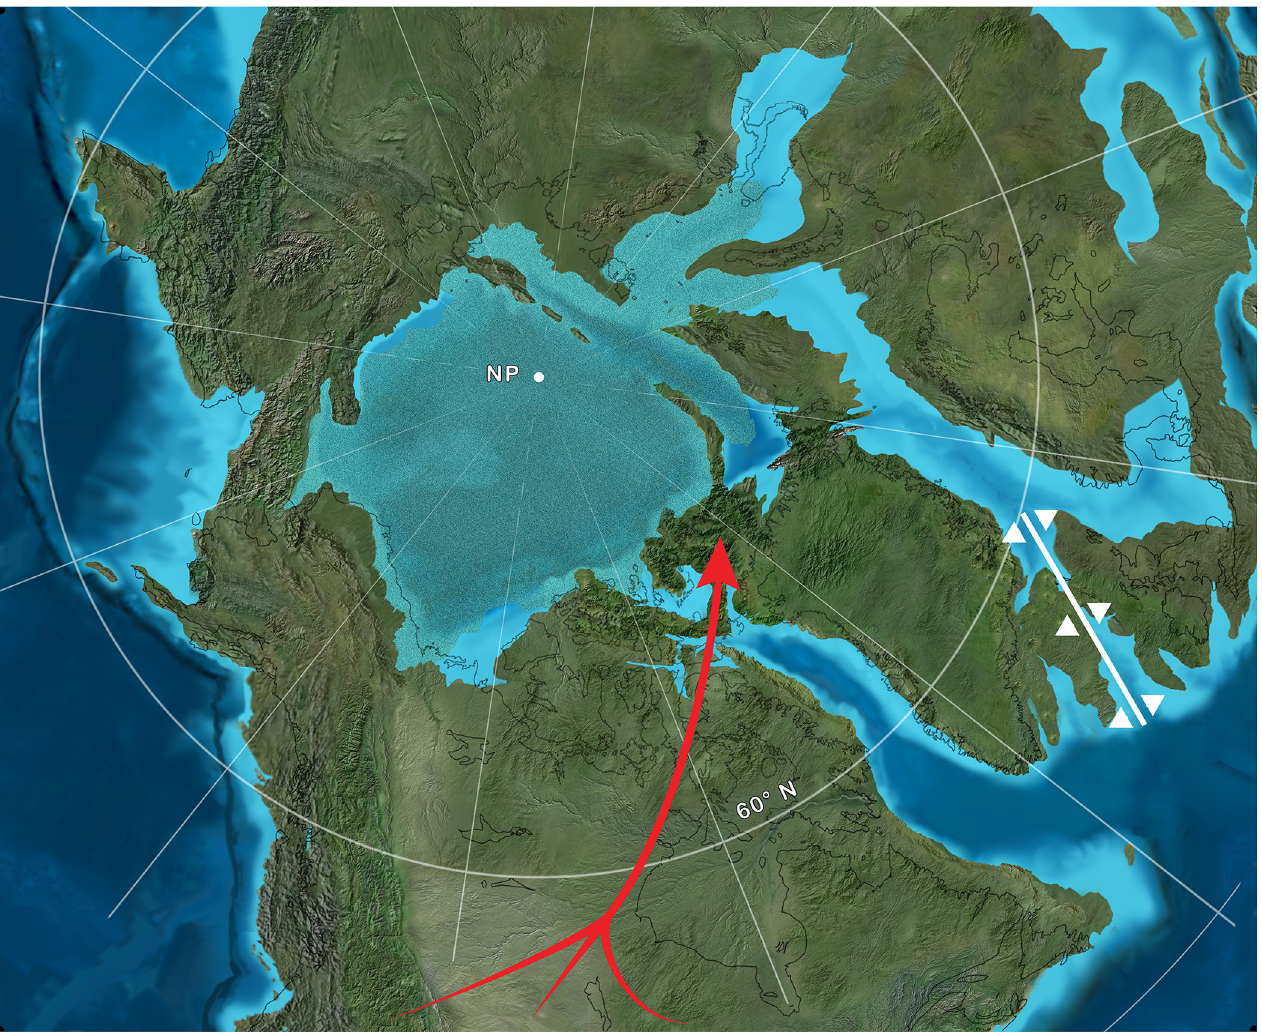
Fig 7. Paleogeographic map of northern Laurasia during the EECO. Red arrow with multiple tails indicates continuity of terrestrial dispersal routes from mid-latitude regions of North America to Ellesmere Island in the late early Eocene. The relative stability of these terrestrial dispersal routes through time facilitated colonization of Ellesmere by multiple North American mammal clades, including Ignacius , Anacodon , Plagiomenidae and Brontotheriidae. In contrast, rifting in the North Atlantic Igneous Province [58], designated by the white graphic between Greenland and what is now Ireland/United Kingdom, had apparently proceeded sufficiently by the late early Eocene as to preempt routine dispersal by terrestrial mammals between western Europe and Ellesmere Island. NP, paleopole position of North Pole. Source map © 2019, Paleogeography of the Arctic, Colorado Plateau Geosystems Inc.